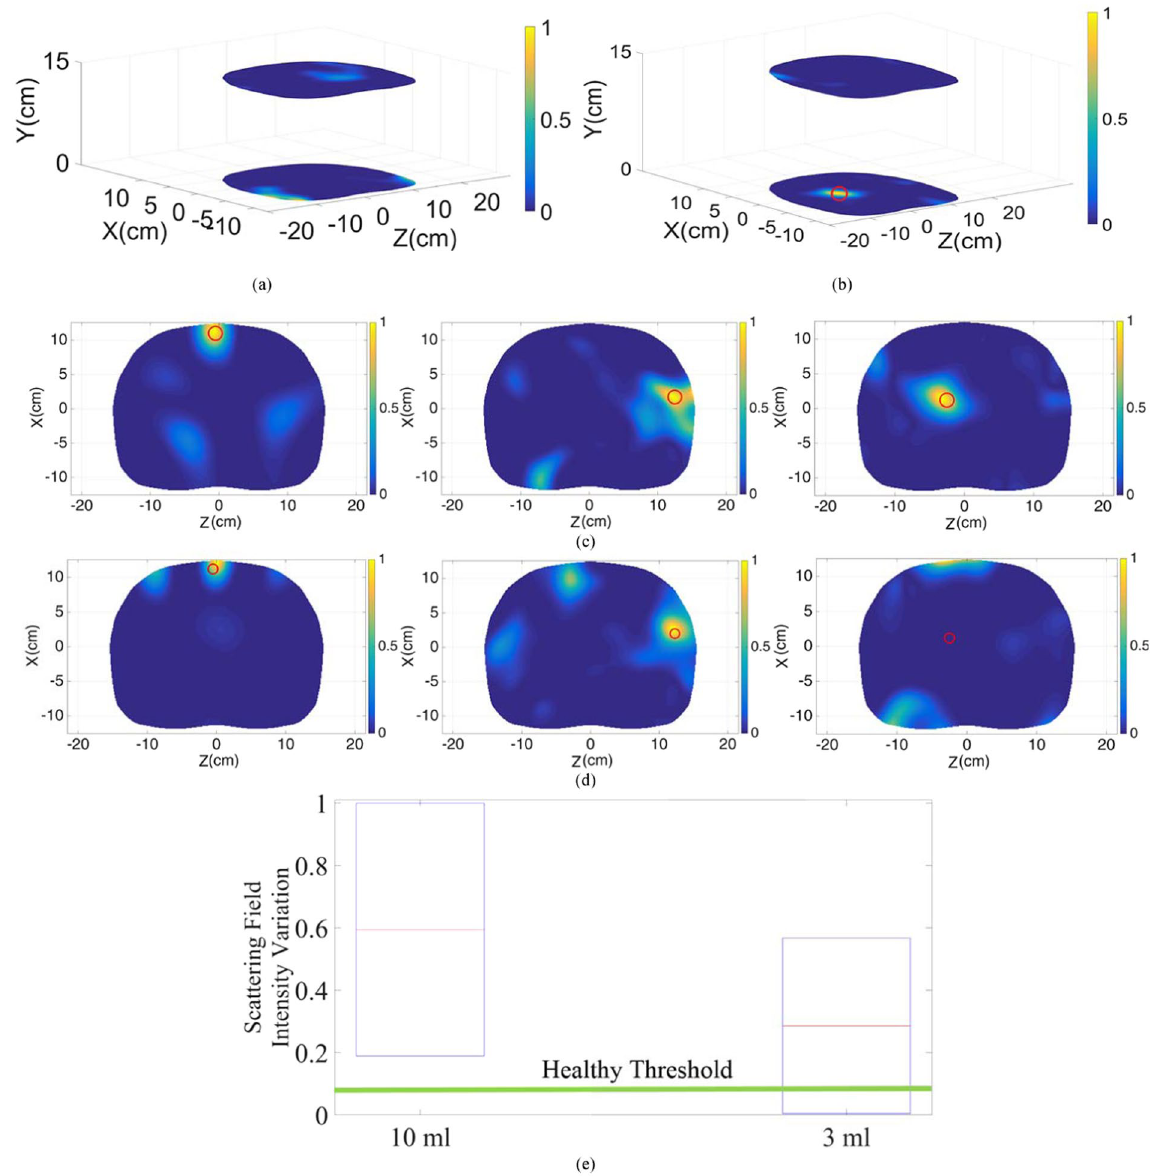
Figure 5. Reconstructed image of the upper and lower regions of the torso in ( a ) healthy case and ( b ) unhealthy case with accumulated fluid inside the thorax area. Subtracted images of the upper and lower regions at three different positions; front side of the torso left), behind ribs middle) and deep inside thorax right) with ( c ) 10 mL and ( d ) 3 mL injected water. ( e ) Scattering field intensity variation diagram for 10 mL and 3 mL inserted water compared to the healthy